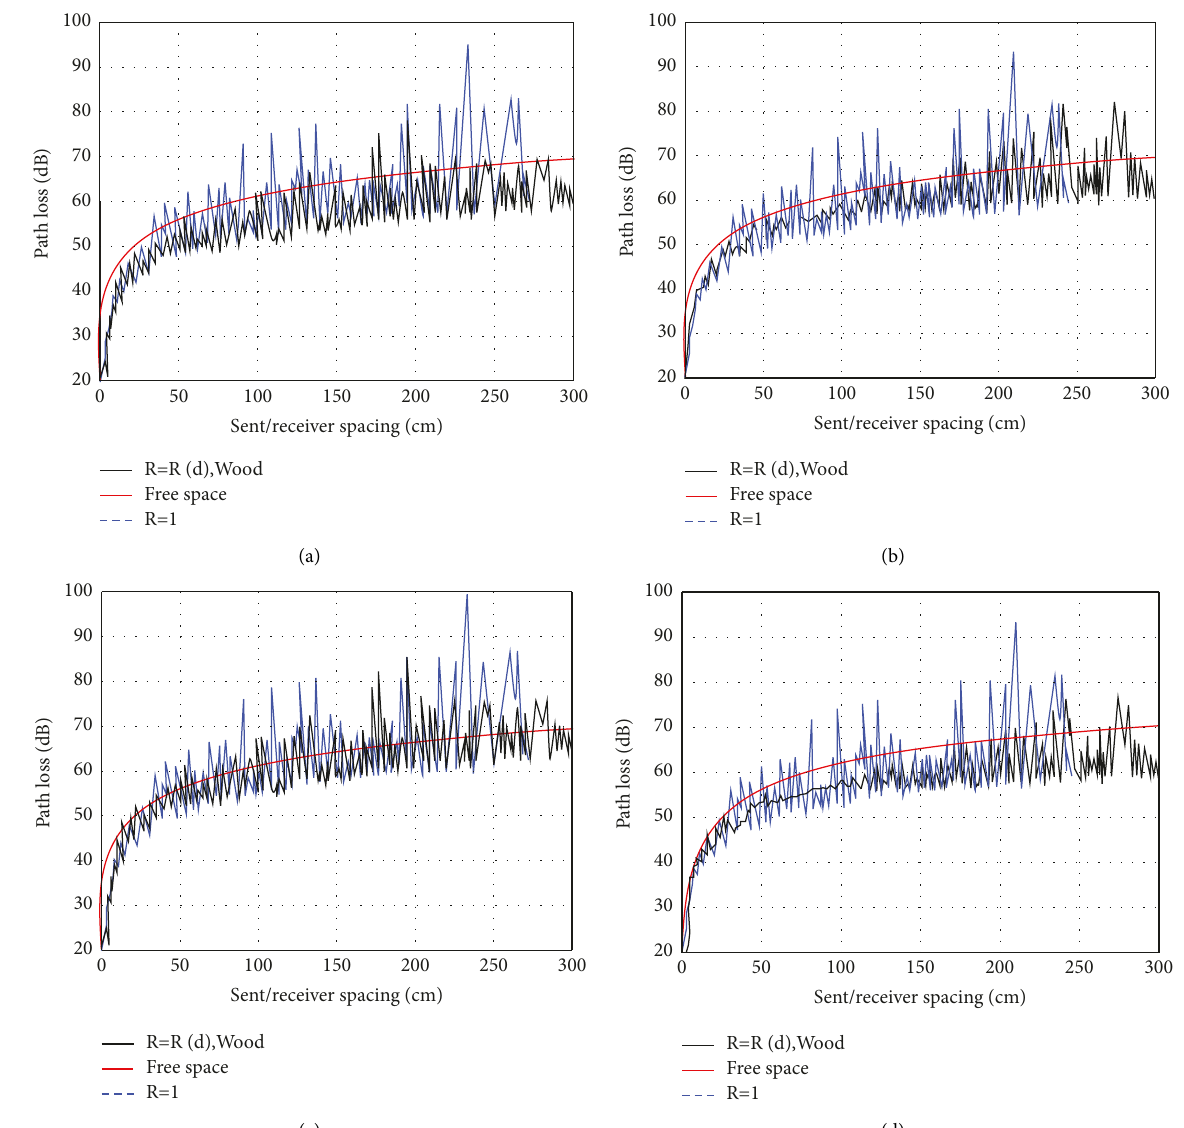
Figure 5: Waveform diagram. (a) Comparison of path loss under horizontal polarization, wood ground, R �− 1, free space. (b) Comparison of path loss under vertical polarization, wood ground, R �− 1, free space. (c) Comparison of path loss under PVC ceiling, R � − 1, free space (horizontal). (d) Comparison of path loss under PVC ceiling, R � − 1, free space